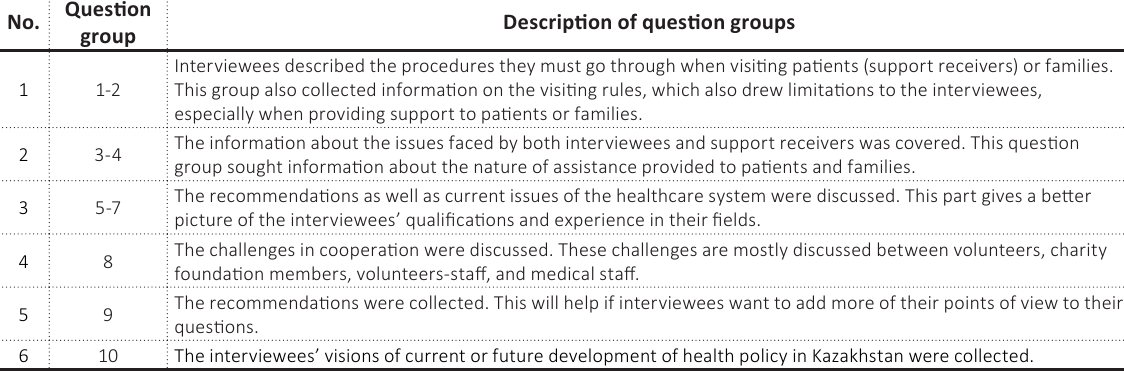
Source: Compiled by the